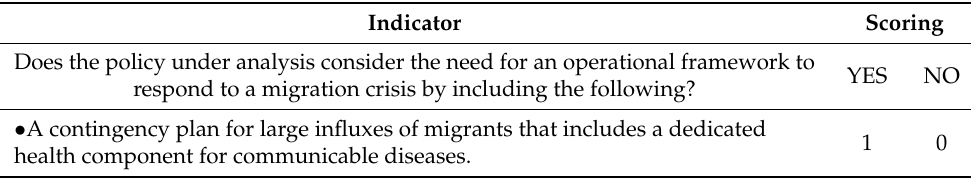
Table 4. Indicator